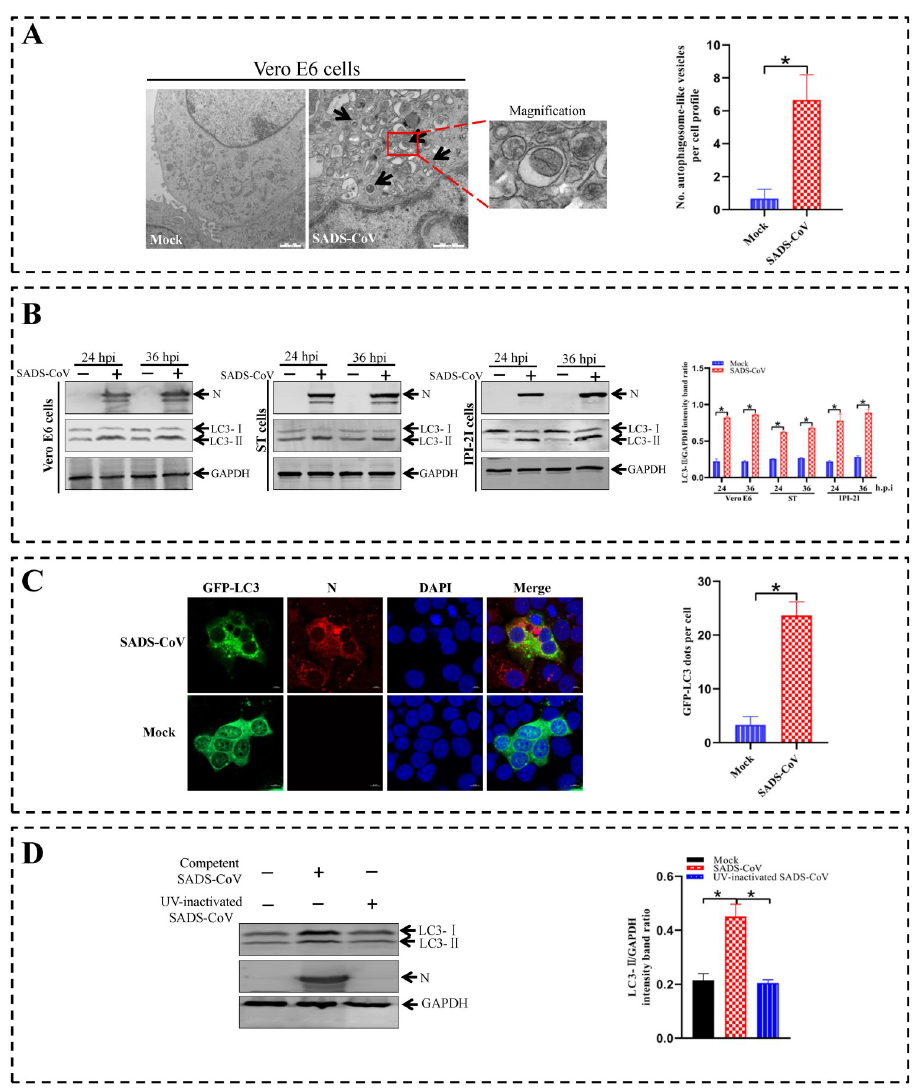
Fig 1. SADS-CoV infection induces autophagy in cultured cells. ( A ) Vero E6 cells are mock-infected or infected with SADS-CoV for 36 h, and then processed for an observation with transmission electron microscopy (TEM). Black arrows indicate characteristics of single- or double-membrane vesicles. Scale bars indicate 1 μ m. ( B ) Vero E6, ST and IPI-2I cells are mock-infected or infected with SADS-CoV at the indicated time points (24 and 36 hpi). Cellular lysates are analyzed by western blotting with anti-LC3 and anti-viral N antibodies. GAPDH is used as a protein loading control. ( C ) Vero E6 cells transfected with pGFP-LC3 plasmids for 24 h are infected with SADS-CoV, and then subjected to a confocal immunofluorescence analysis at 36 hpi. The puncta of GFP-LC3 (green) are counted in viral N protein (red) positive cells. ( D ) Vero E6 cells are inoculated with competent SADS-CoV or UV-inactivated SADS-CoV for 36 h. Subsequently, cellular lysates are analyzed as described in B. Means and SD (error bars) of three independent experiments are indicated ( � P <